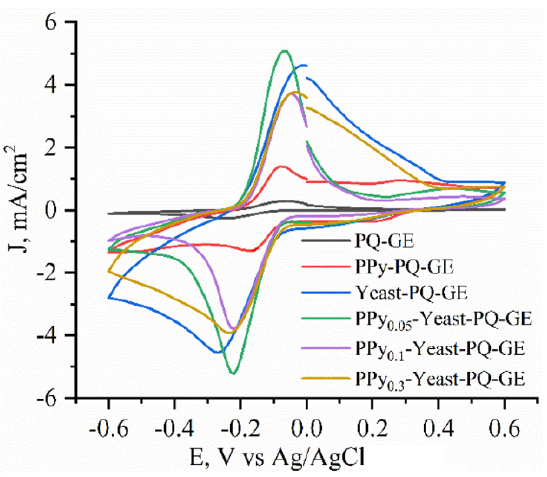
Figure 5. Cyclic voltammograms of a bare graphite electrode (GE) modified with PQ, a PPy–PQ-modified GE, a yeast–PQ-modified GE, and a PPy–yeast–PQ-modified GE at different pyrrole concentrations. Measurements were performed in phosphate buffer solution with 0.75 mM potassium ferricyanide and 50 mM glucose.